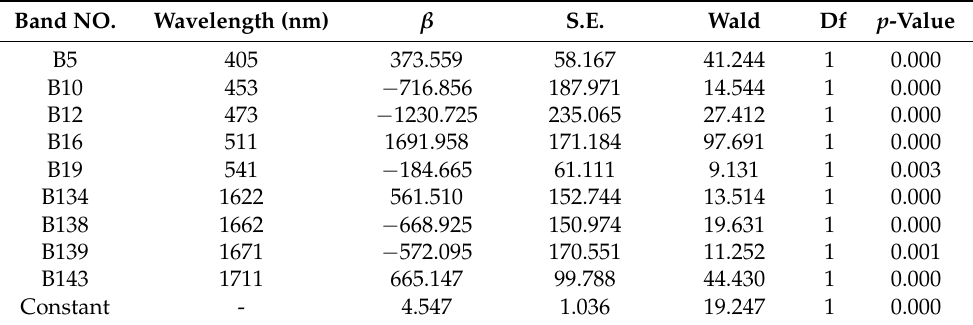
Table 2. NOAI logistic model parameters derived from BLR and Wald test. Band NO.